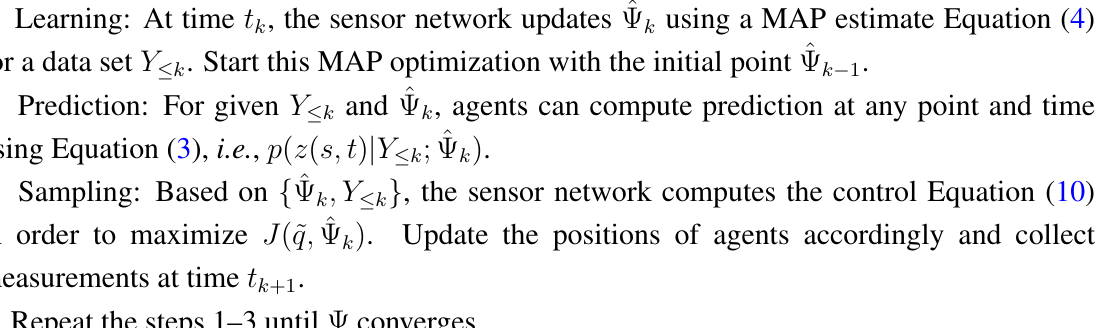
Table 1. An adaptive sampling strategy for mobile sensor